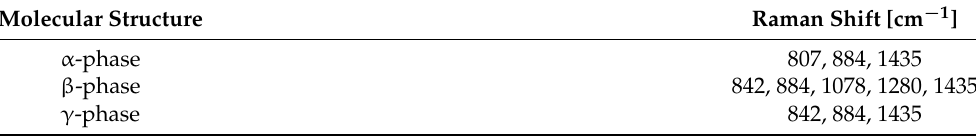
Table 3. Identification of bonds of crystalline phases of PVDF.